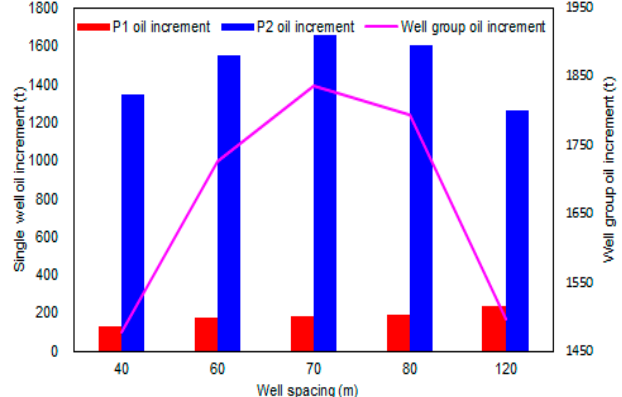
Figure 25. Effect of well spacing on oil increase.